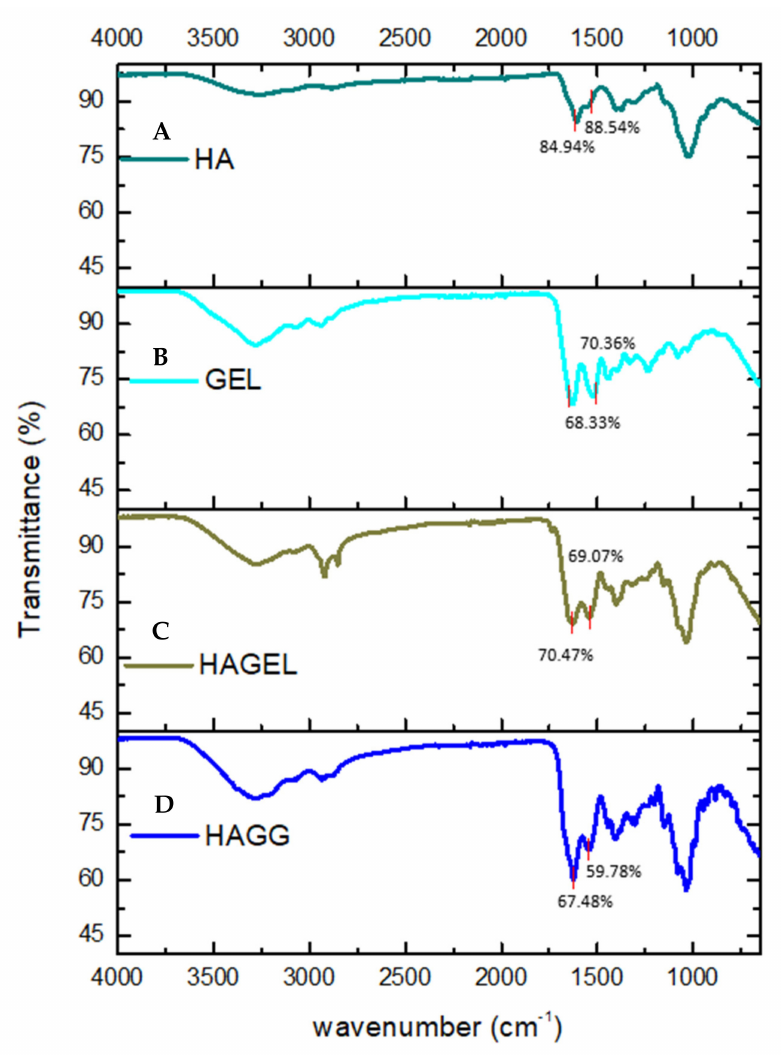
Figure 3. FTIR spectra of ( A ) pristine hyaluronic acid (HA), ( B ) pristine gelatin (GEL), ( C ) hyaluronic acid-gelatin (HAGEL) and ( D ) hyaluronic acid-gelatin–genipin (HAGG).